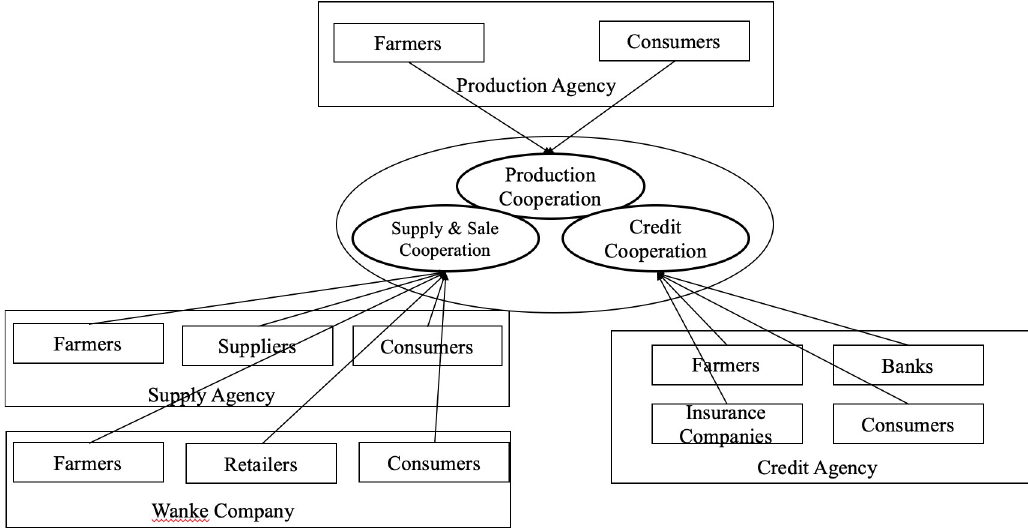
Fig 4. The Meiyu Cooperative’s trinity supply chain mode.